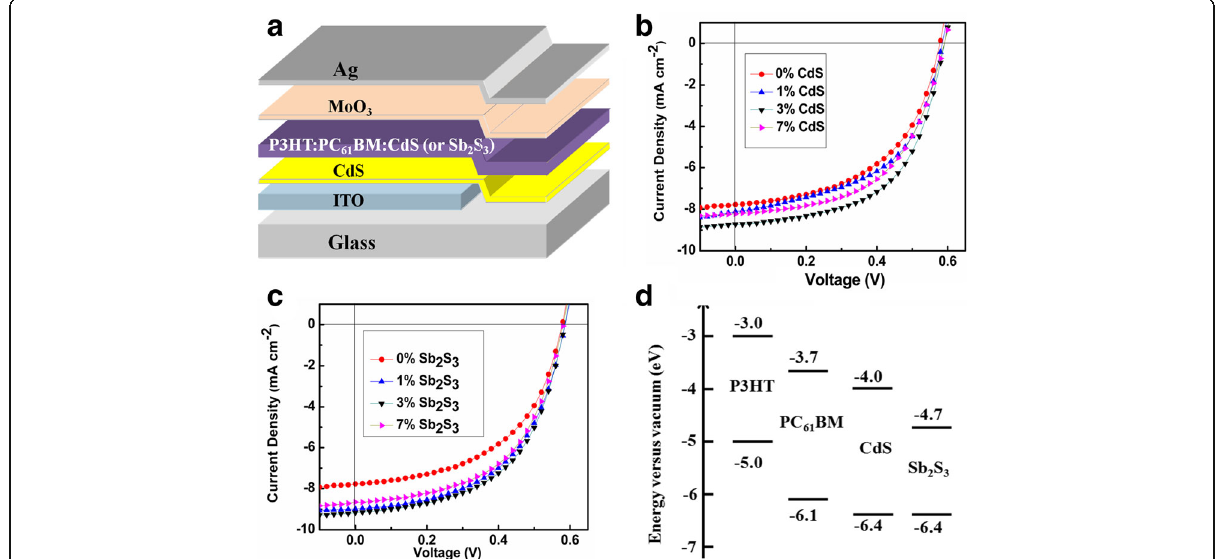
Fig. 3 a Schematic diagram of the HSCs. b J – V curves of the HSCs based on P3HT:PC 61 BM: CdS with different wt.% of CdS nanocrystals. c J – V curves of the HSCs based on P3HT:PC 61 BM: Sb 2 S 3 with different wt.% of Sb 2 S 3 nanocrystals. d Energy band diagram of the materials used in the active layer in the